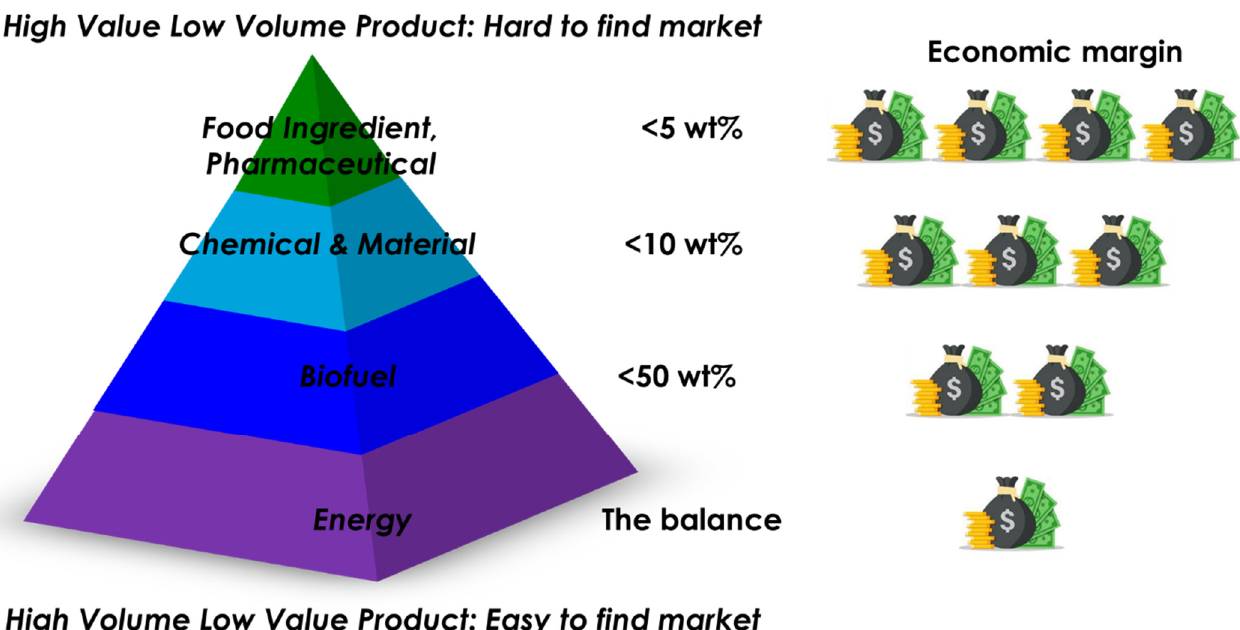
Figure 8. Bioeconomy products pyramid.